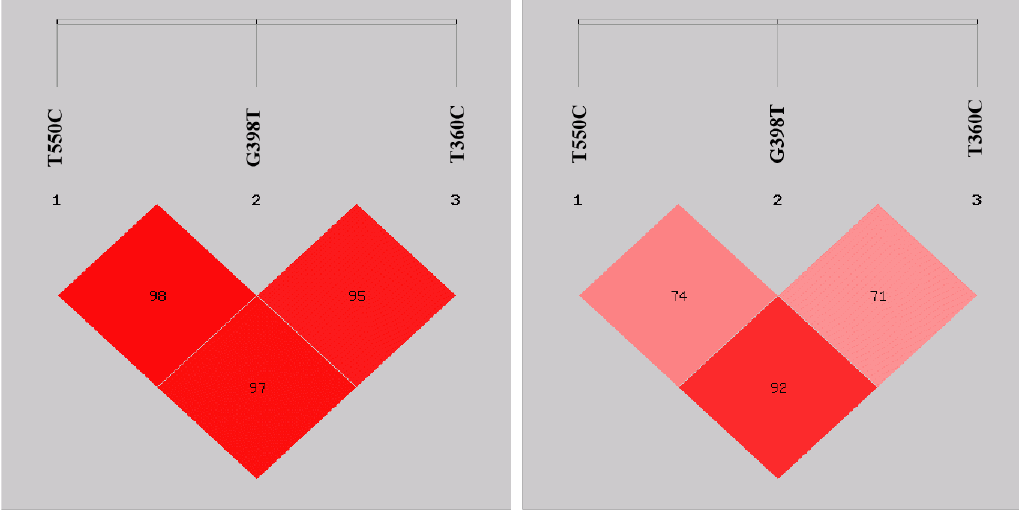
Figure 6. D’ values (left) and r 2 values (right) of pairwise linkage disequilibrium analysis of the IL-8 gene promoter region.